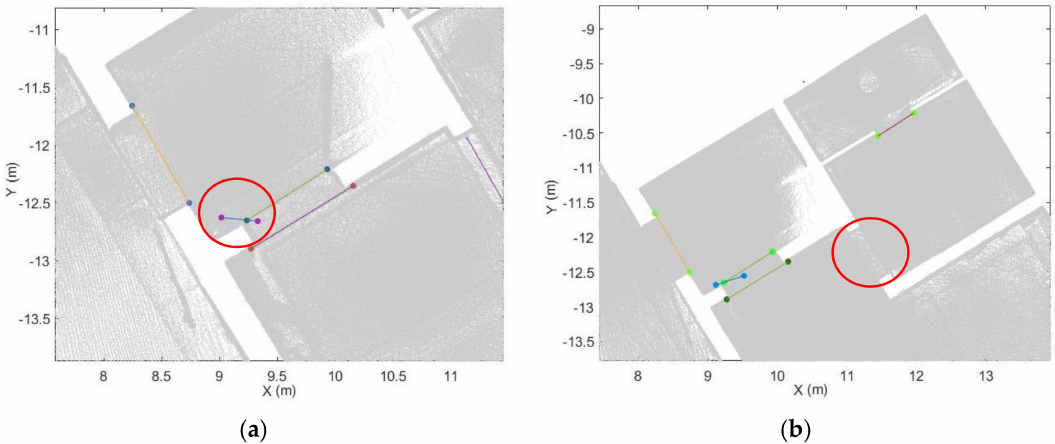
Figure 17. Influence of the parameters r _1 and Nd . ( a ) r 1 = 0.5 ( m ) and Nd = 6; and ( b ) r 1 = 0.3 ( m ) and Nd = 8.